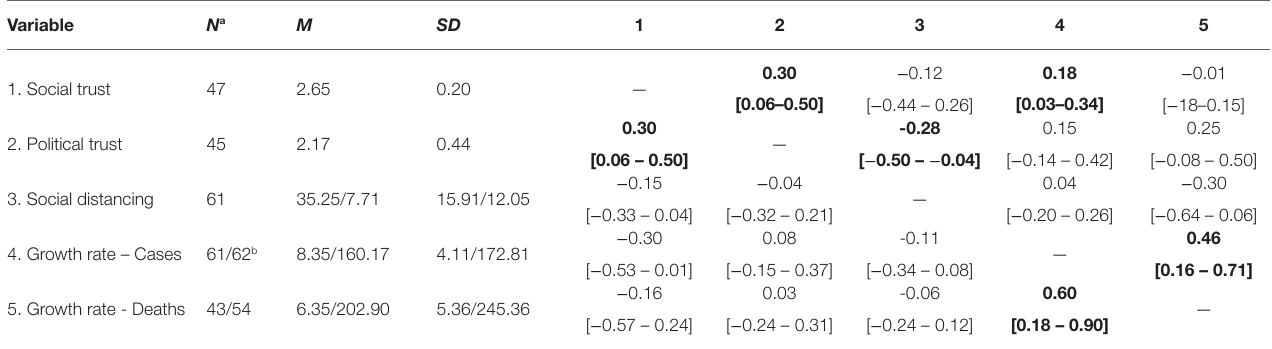
TABLE 4 | Descriptive statistics and correlations with 95% bootstrapped confidence intervals are presented for Wave 1 (right-hand side) and Wave 2 (left-hand side) in Study 3.